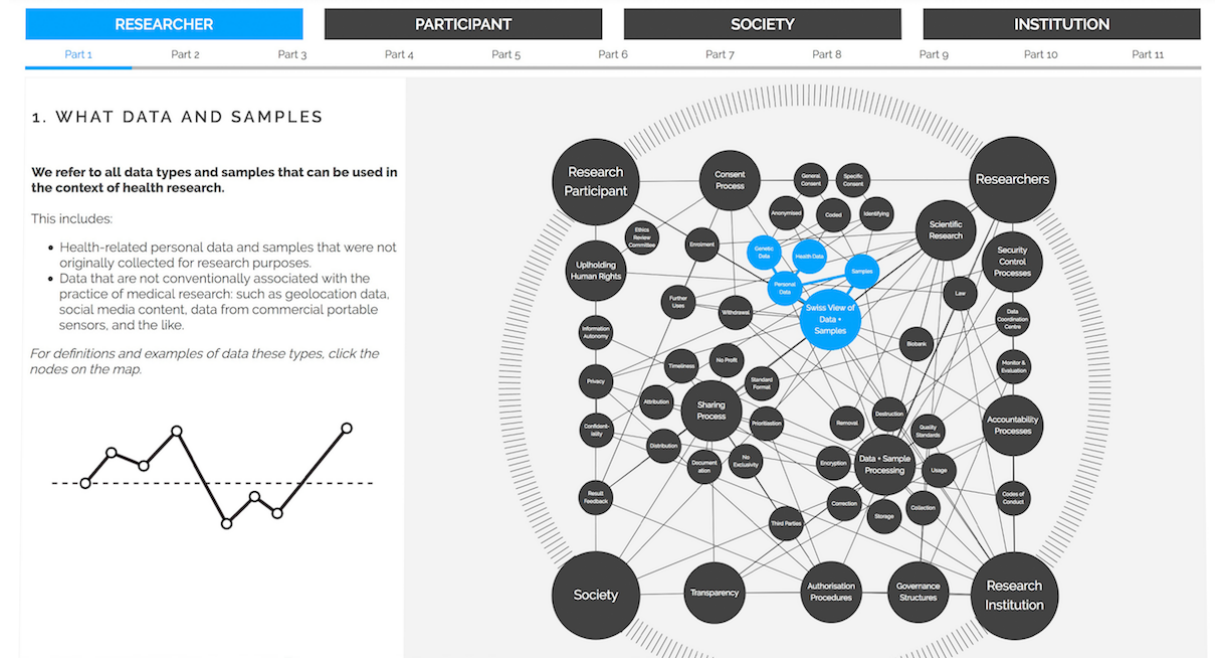
Figure 3. Screenshot of the interactive systems